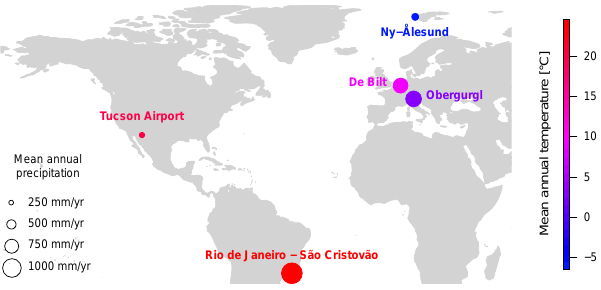
Figure 2. Map of stations investigated in this study. Dot size rep- resents the mean annual precipitation, whereas the colour of each station indicates the mean annual